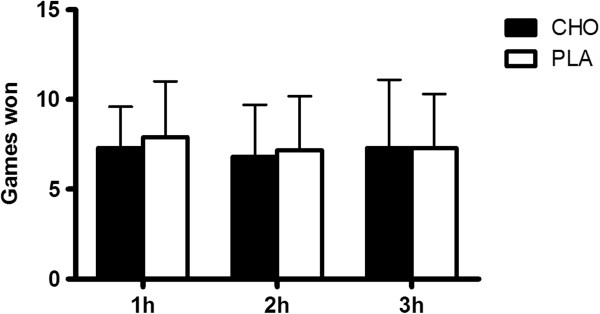
Sum of games won between PLA and CHO conditions.